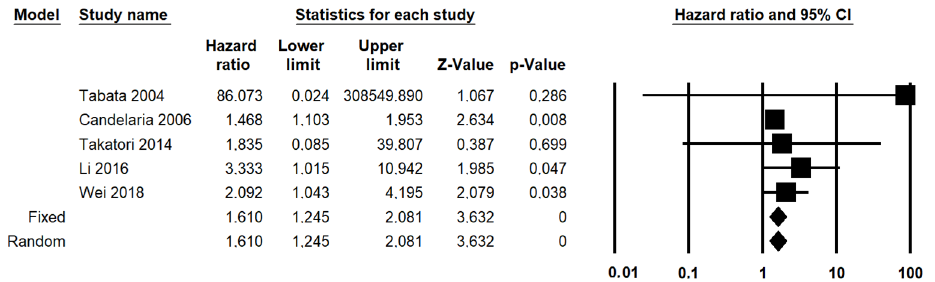
Figure 4. Forest plot reporting hazard ratio (HR) for overall survival in patients with cervical cancer treated, underwent neoadjuvant therapy, obtained by dichotomizing pathological response as “any residual tumor” vs. “complete disappearance of the